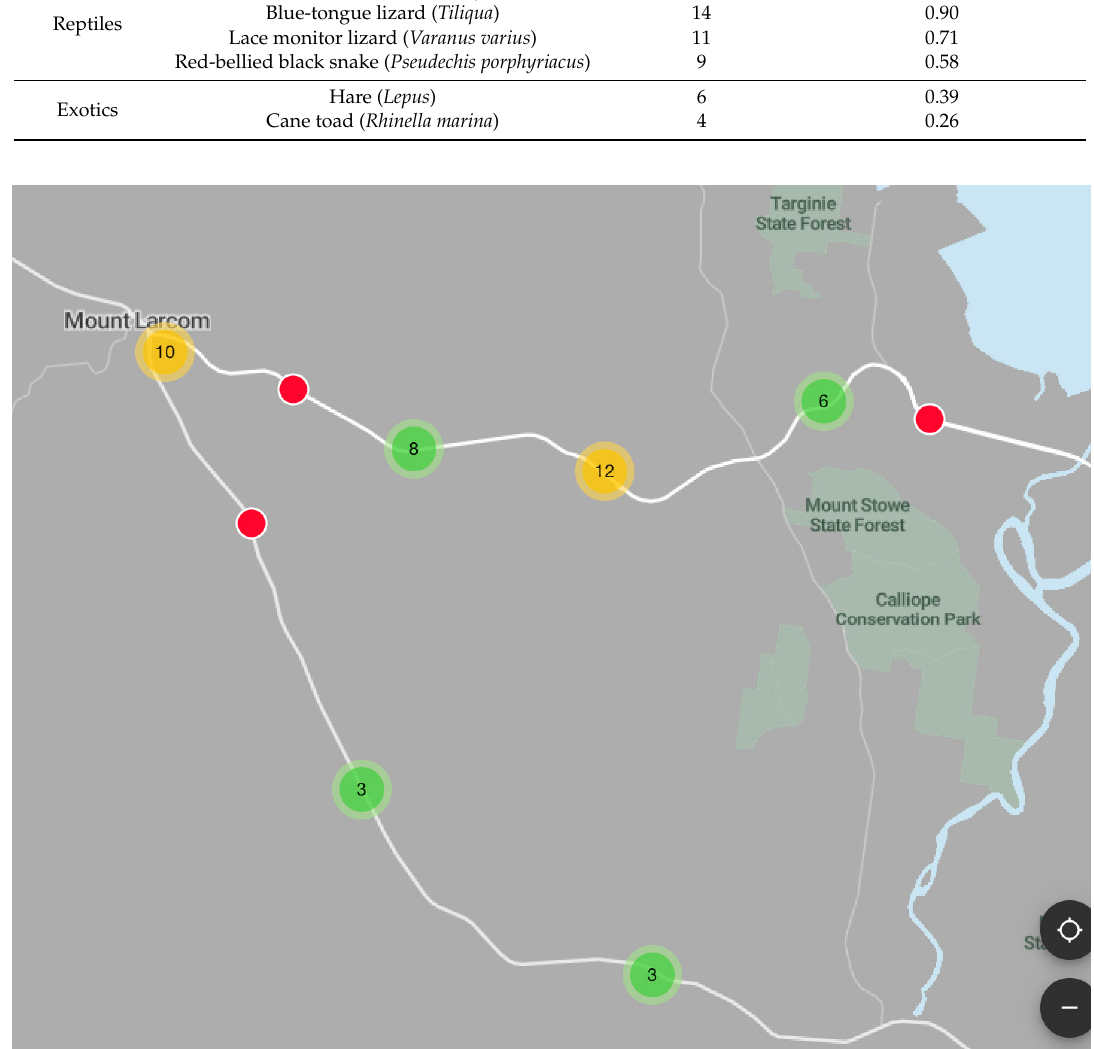
Figure 3. Roadkill hotspot on 20 km of highway between Mount Larcom and east towards Mount Stowe State Forest, Queensland.